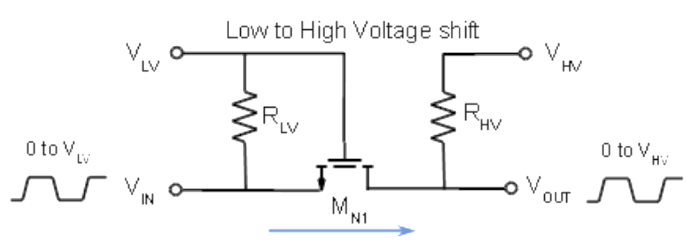
Figure 2. Principle of a voltage shifter: “From Low voltage to High voltage”